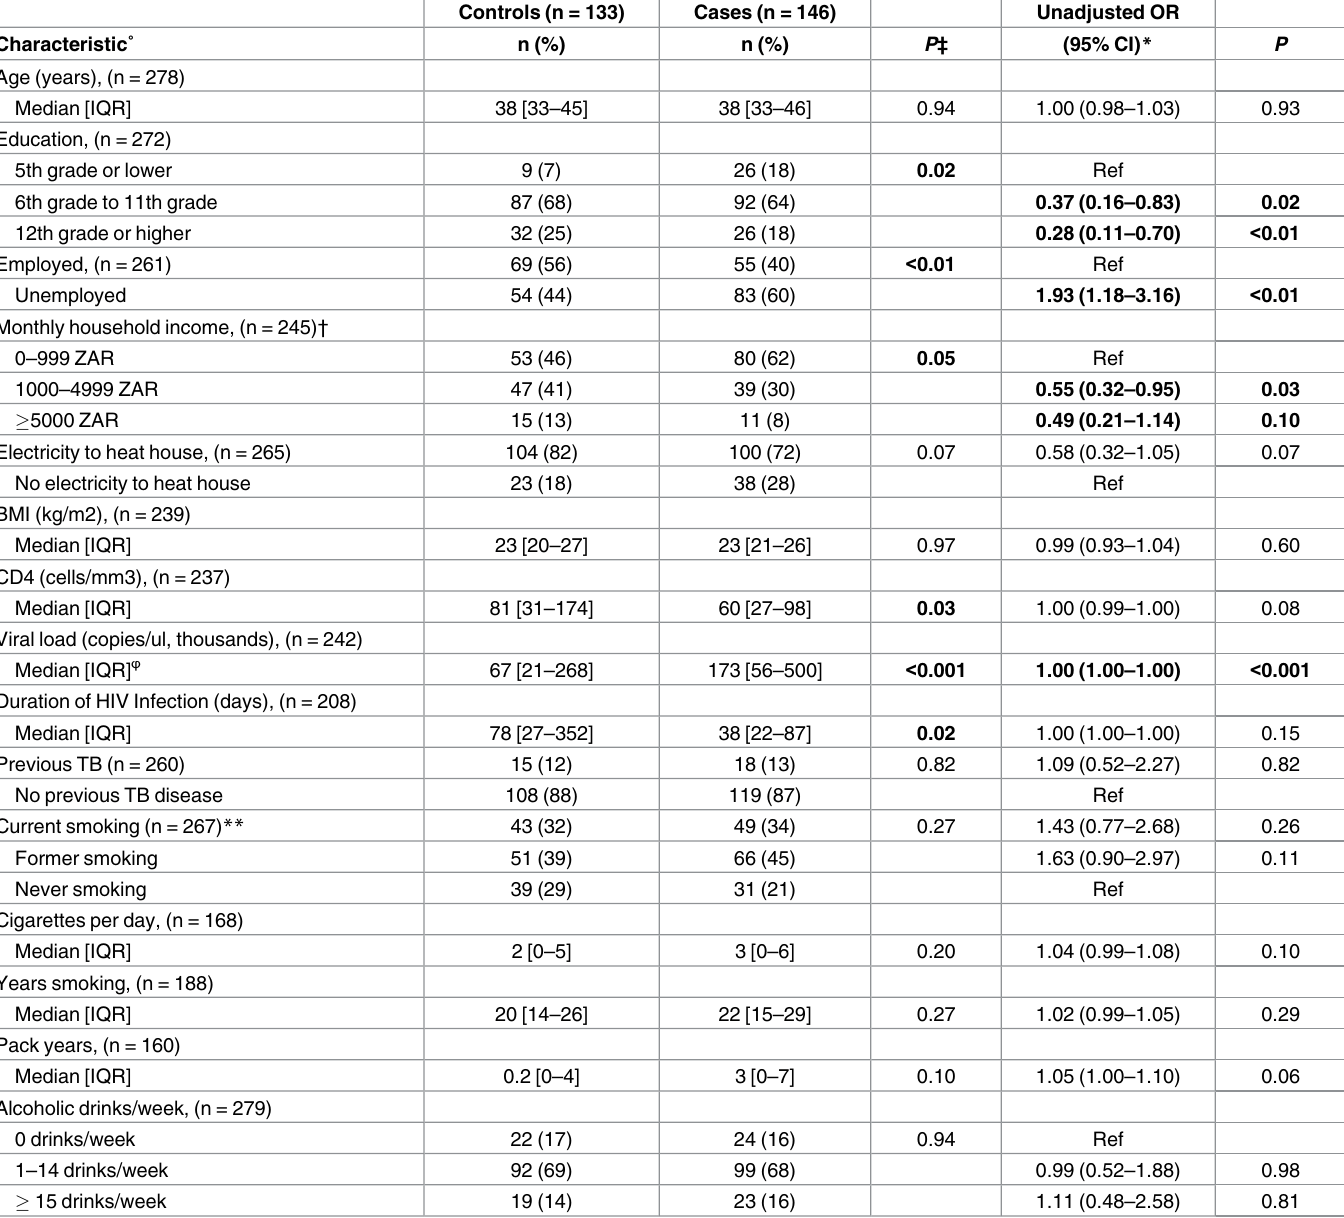
Table 1. Socio-demographic and smoking history characteristics of controls without and cases with pulmonary TB in Soweto, Johannesburg, South Africa (n =